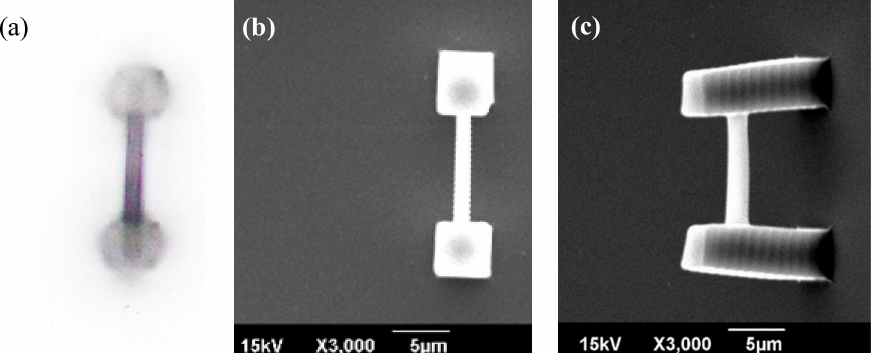
Figure 5. ( a ) Optical microscope normal incidence; ( b ) SEM normal incidence and ( c ) SEM 45 ◦ perspective views of a typical double pillar bar. The normal view allows the width of the bar to be measured and the 45 ◦ perspective give estimates of the depth of the